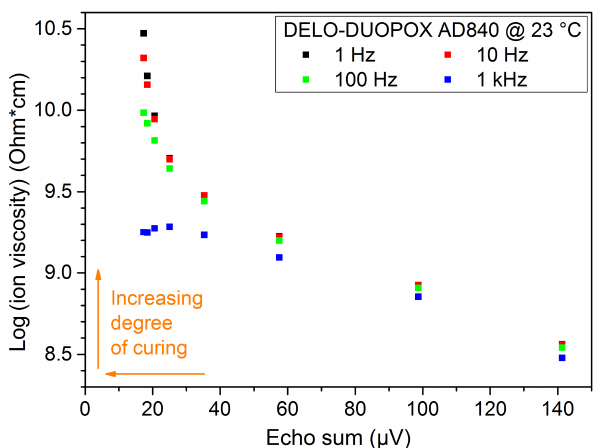
Figure 20. Comparison of ion viscosity from DEA measurements and echo sums from NMR experiments at the same times for the 2C adhesive (DELO-DUOPOX AD840) cured at room